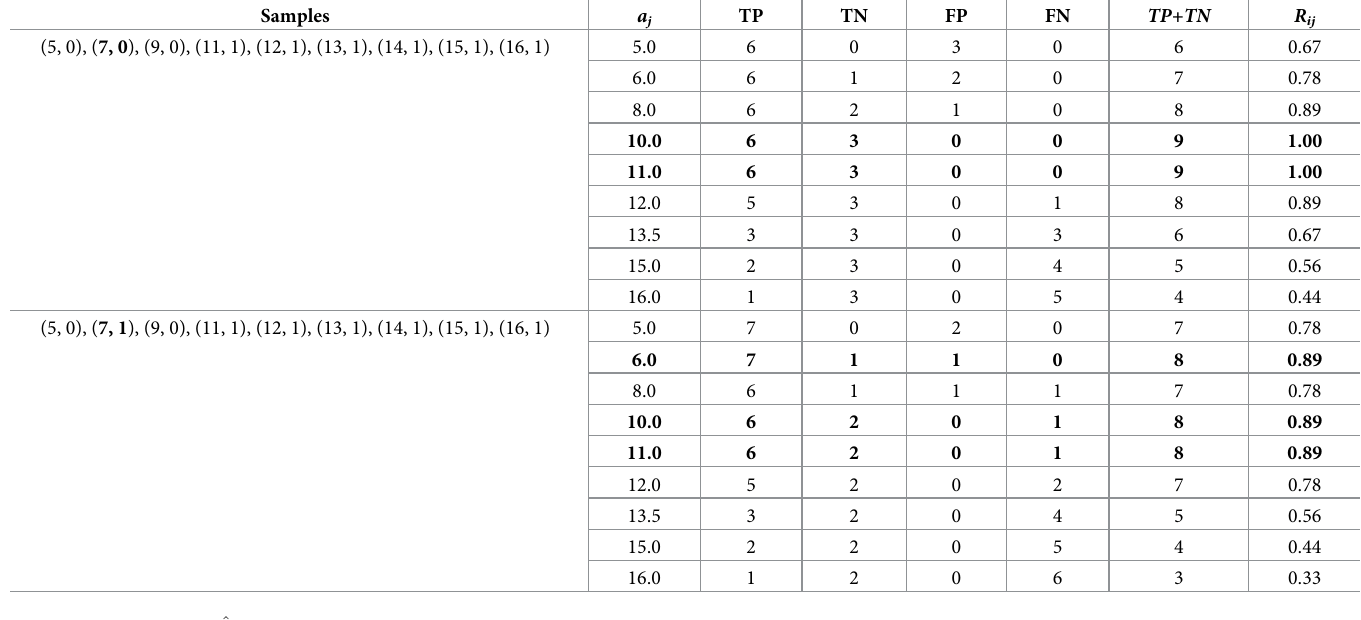
Table 1. Estimate of Q iz based on 9 pairs of repeated outcomes ( x ij , g ij ) from subject i . Samples